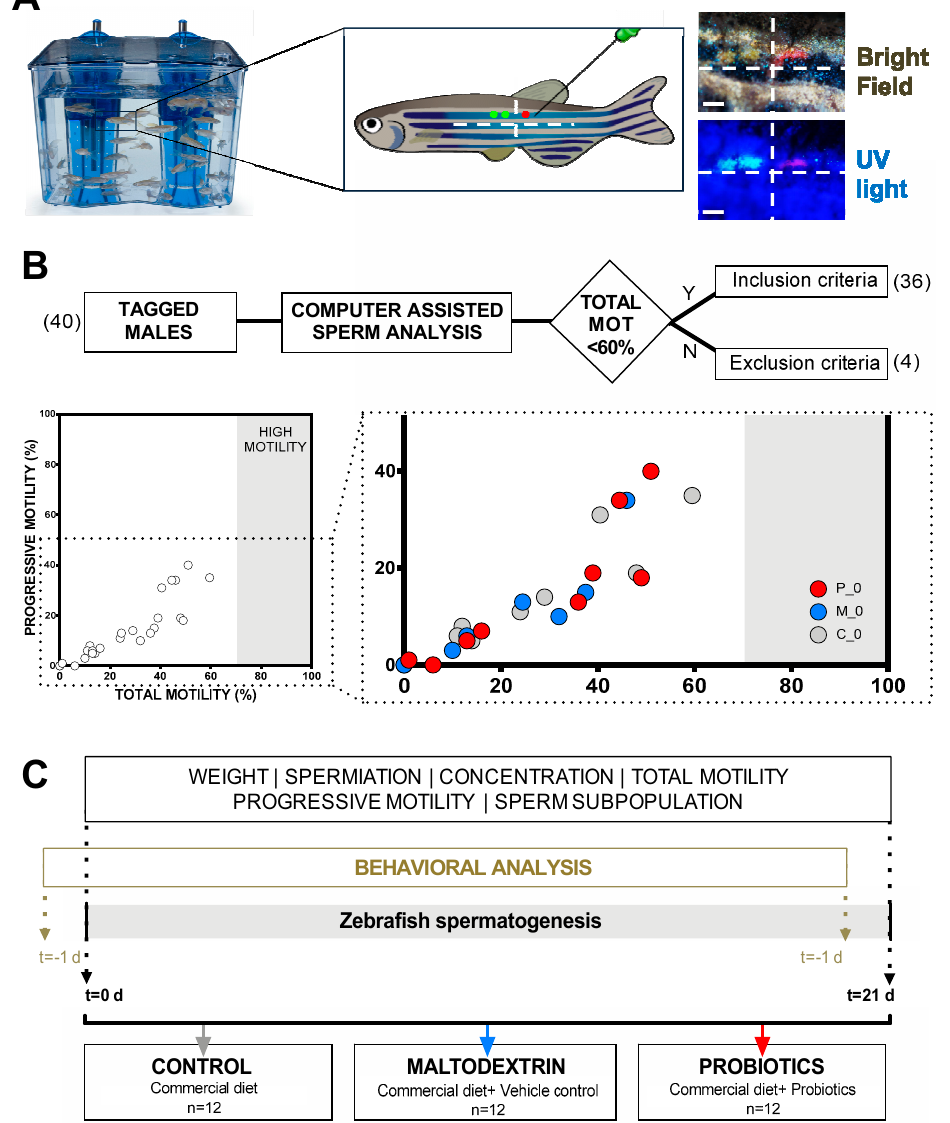
Figure 1. Study design summary. ( A ) Animals participating in the experiment ( n = 40) were tracked with fluorescent visible implant elastomers. Each male carried a unique code visible under white and UV light. ( B ) Only males that reached the inclusion criteria described in the flowchart ( n = 36) were selected for creating homogeneous experimental groups in terms of total motility. ( C ) Each group ( n = 12) received a different diet during 21 days corresponding to a Danio rerio spermatogenesis cycle. “C”, “M”, and “P” refer to the experimental groups: Control, maltodextrin, and probiotics,